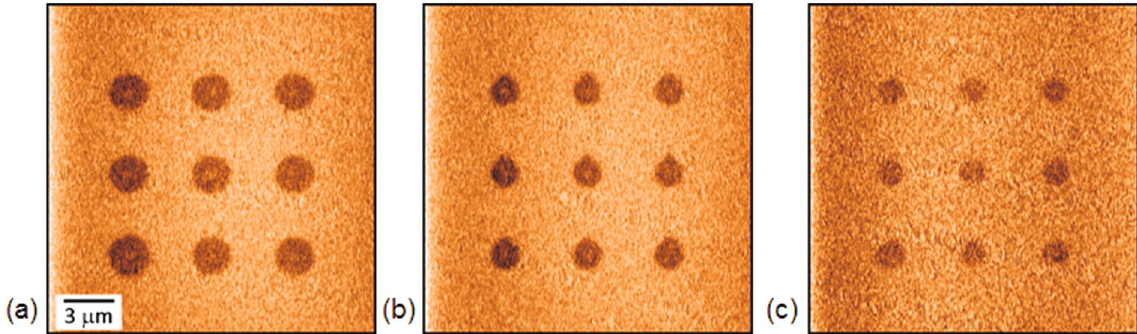
Figure 6. The PFM images of polarized regions created by discrete scanning in SBN61:Ce at various temperatures: ( a ) 23 °C, ( b ) 39 °C, ( c ) 55 °C. U dc = 100 V, pulse duration 10 s.